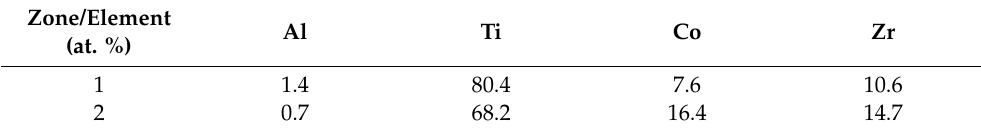
Table 4. Results of EDX area analysis from Figure